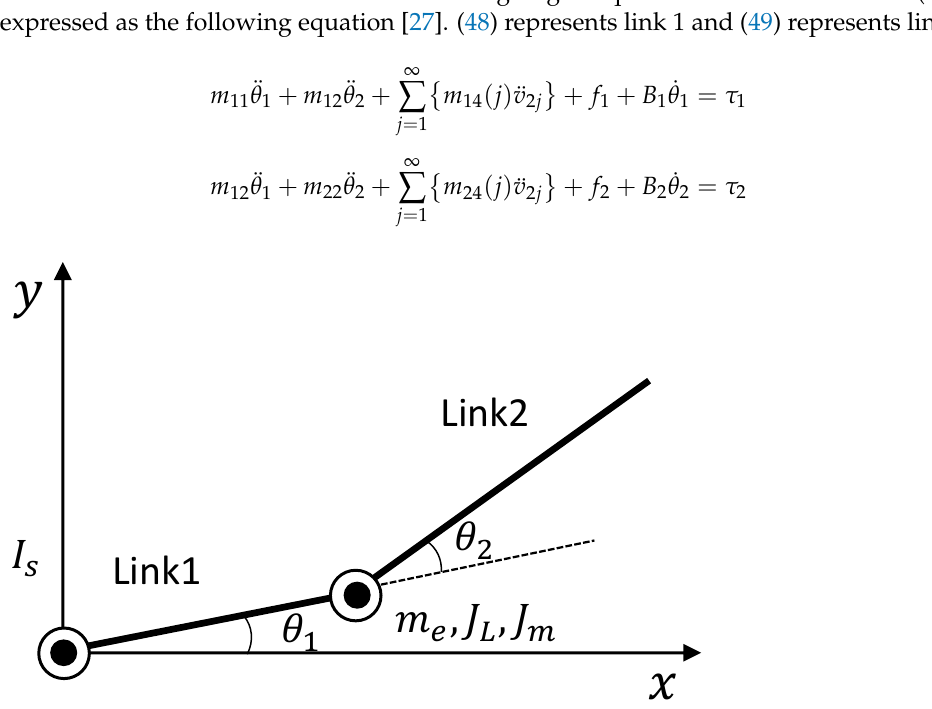
Figure 3. Robot arm used in this research (Conceptual diagram).